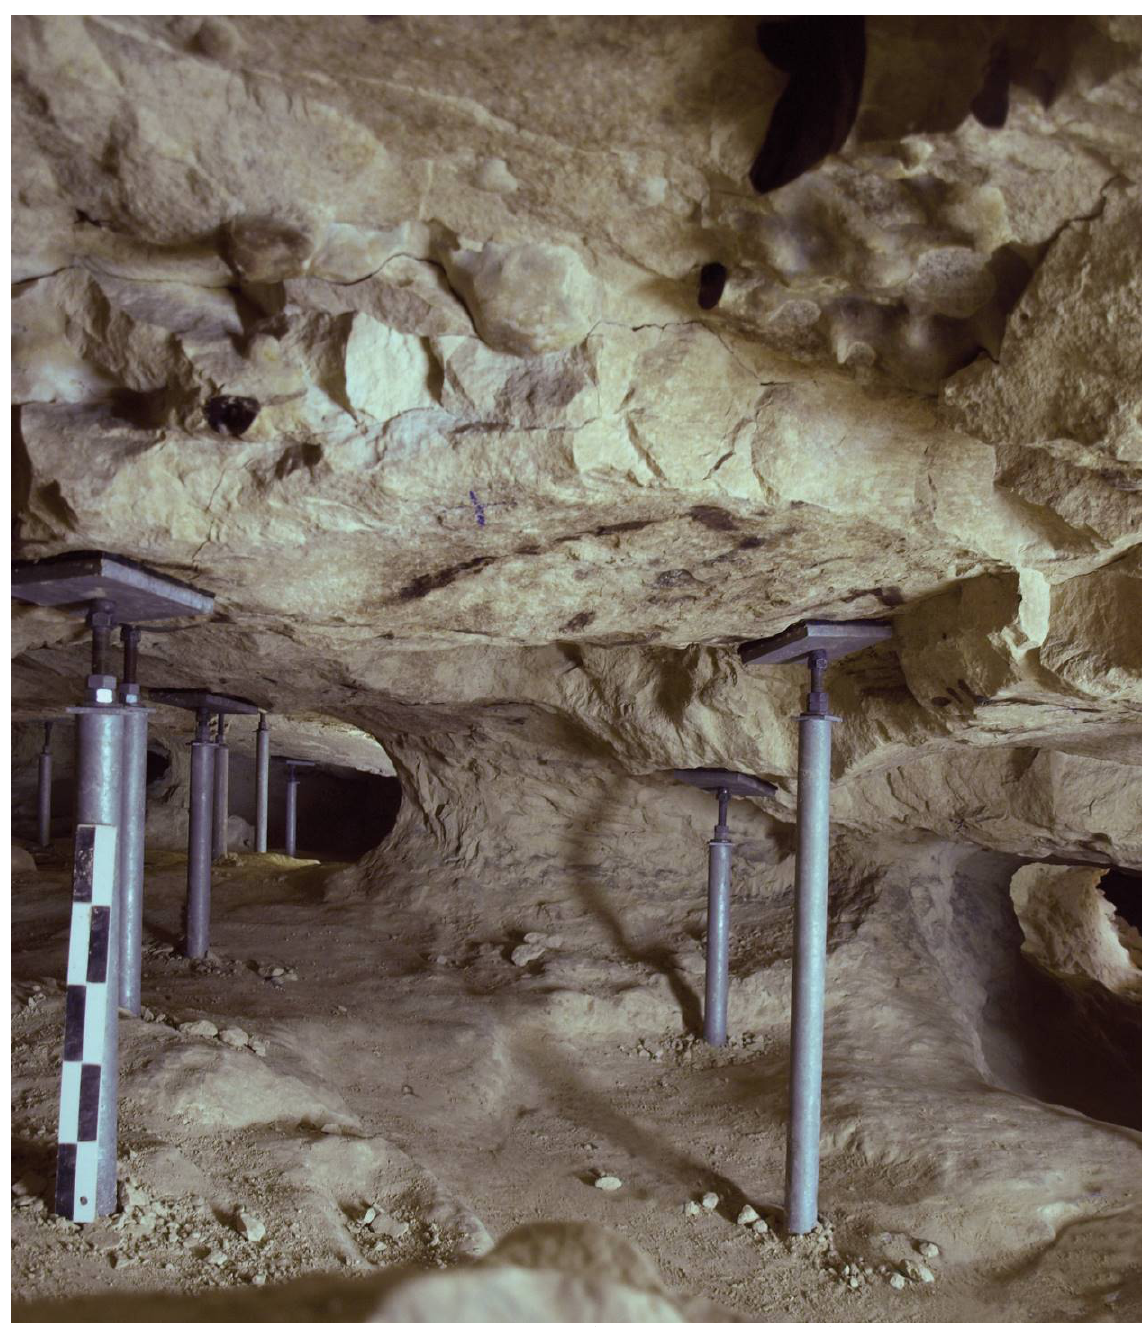
Figure 21. Spiennes, Camp-à-Cayaux. Extraction gallery (1912-1914 excavations). Photo D. Werra,